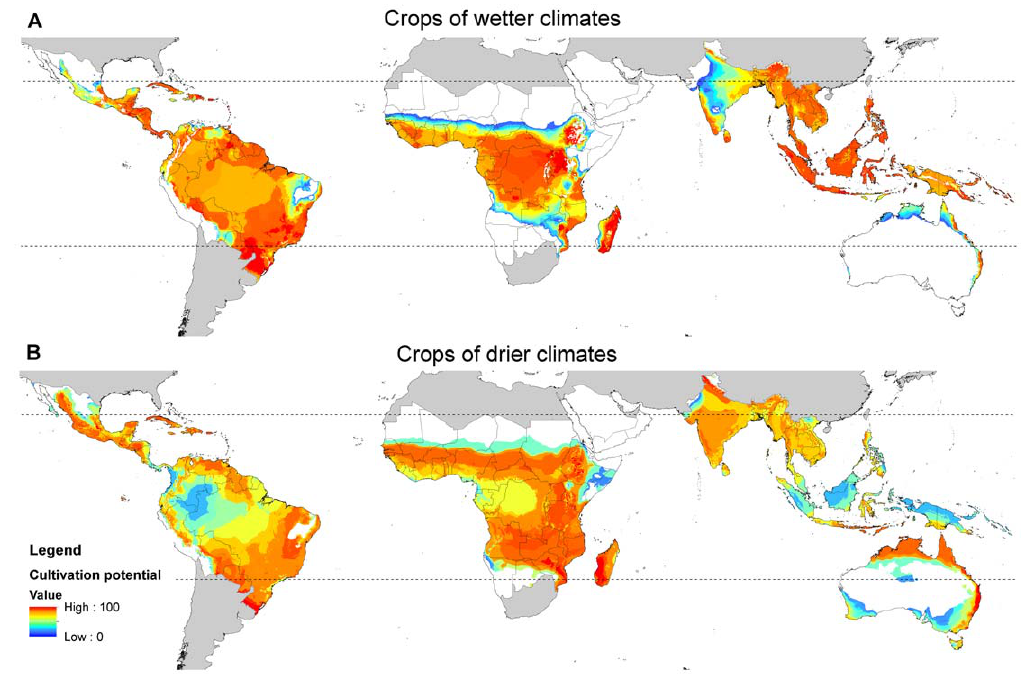
Figure 5. Areas of land with cultivation potential for selected crops of (A) wetter climates and (B) drier climates. Maps are based on four wetter-climate crops (cassava, rice, sugar cane and oil palm) and eight drier-climate crops (beans, cow peas, groundnut, maize, millet, sorghum, soybeans and wheat). The map shows cultivation potential for the crop for which each 5-min grid cell is most suitable. Cultivation potential is calculated as the ‘‘agro-climatically attainable yield’’ for each rainfed crop as a percentage of the global maximum for that crop [55].